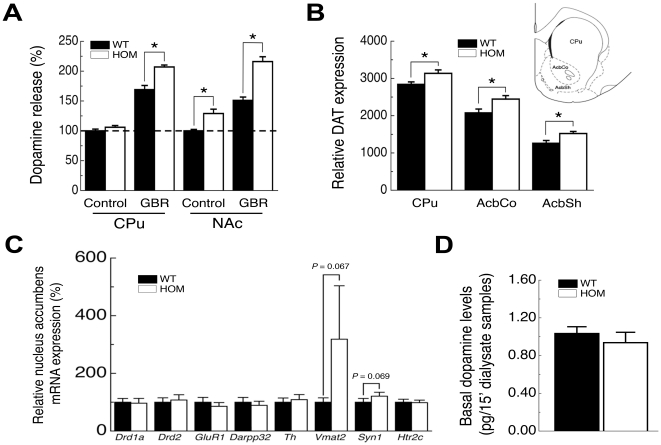
Striatal dopamine system dynamics in pmch
−/− rats.(A) Electrically evoked control dopamine release is similar between genotypes in the CPu, but is increased in the NAc of pmch
−/− rats compared to pmch
+/+ rats. Electrically evoked dopamine release in both the CPu and NAc of pmch
−/− rats is increased compared to pmch
+/+ rats after treatment with GBR12909, a highly specific dopamine transporter (DAT) inhibitor. Data is shown in comparison to wild-type control release as 100% (dotted line; *P<0.005, Students' t-test; n = 4 per group). (B) DAT expression is increased in the CPu, AcbCo, and the AcbSh of pmch
−/− rats compared to pmch
+/+ rats. Brain areas are indicated on an atlas section from Paxinos and Watson [72] (*P<0.05, Students' t-test; n = 8–11 per group). (C) Relative gene expression of a subset of genes involved in dopaminergic storage capacity and dopamine signaling in the NAc of adult pmch
+/+ and pmch
−/− rats revealed an increased trend of Vmat2 and Syn1 in pmch
−/− rats compared to pmch
+/+ rats (P = 0.067 and P = 0.069 by Students' t-test, respectively; n = 8–9 per group). (D) Average basal extracellular AcbSh dopamine levels did not differ between fasting pmch
+/+ and pmch
−/− rats (n = 7 per group). Data are shown as mean ± S.E.M.